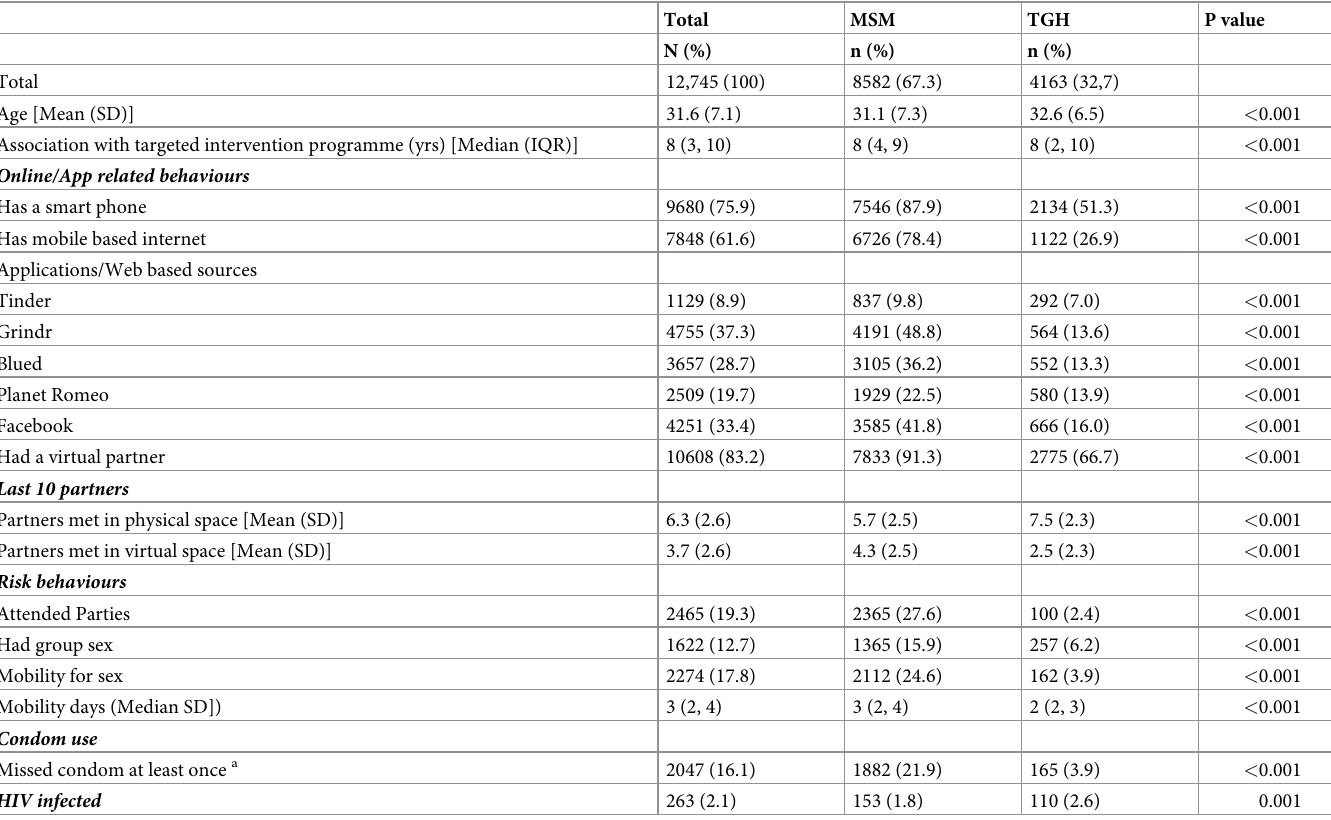
Table 1. Table comparing the demographics, internet practices, and high-risk behaviours of 8582 MSM and 4163 TGH, Mumbai,